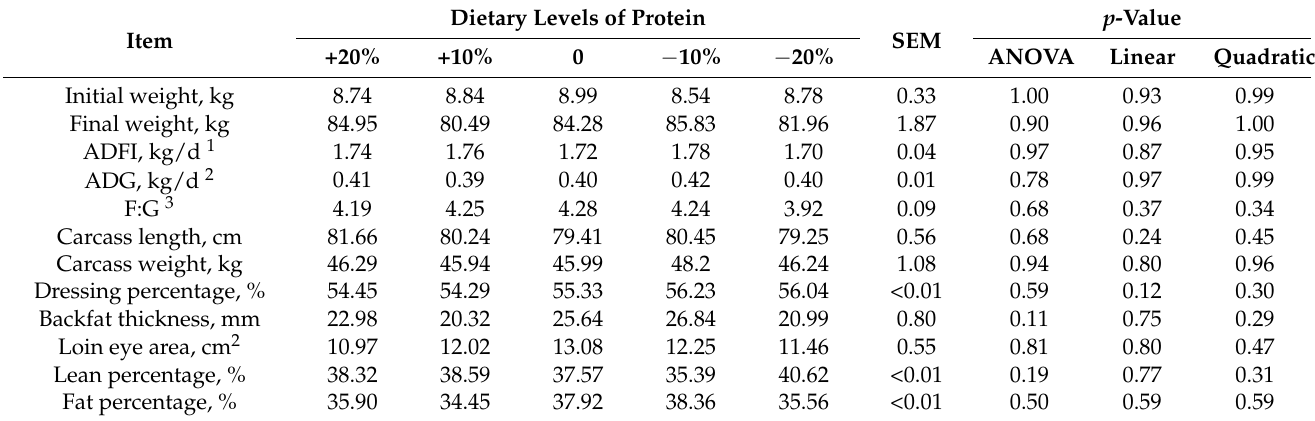
Table 4. Effects of long-term protein restriction on growth performance and carcass traits of Shazil- ing pigs.